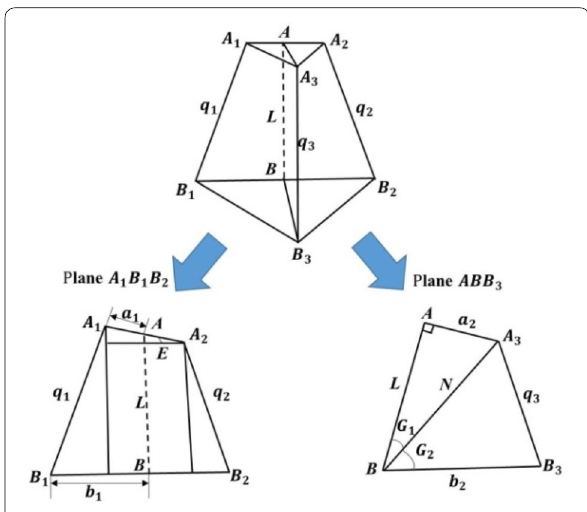
Figure 3 Schematic diagram of the parallel mechanism